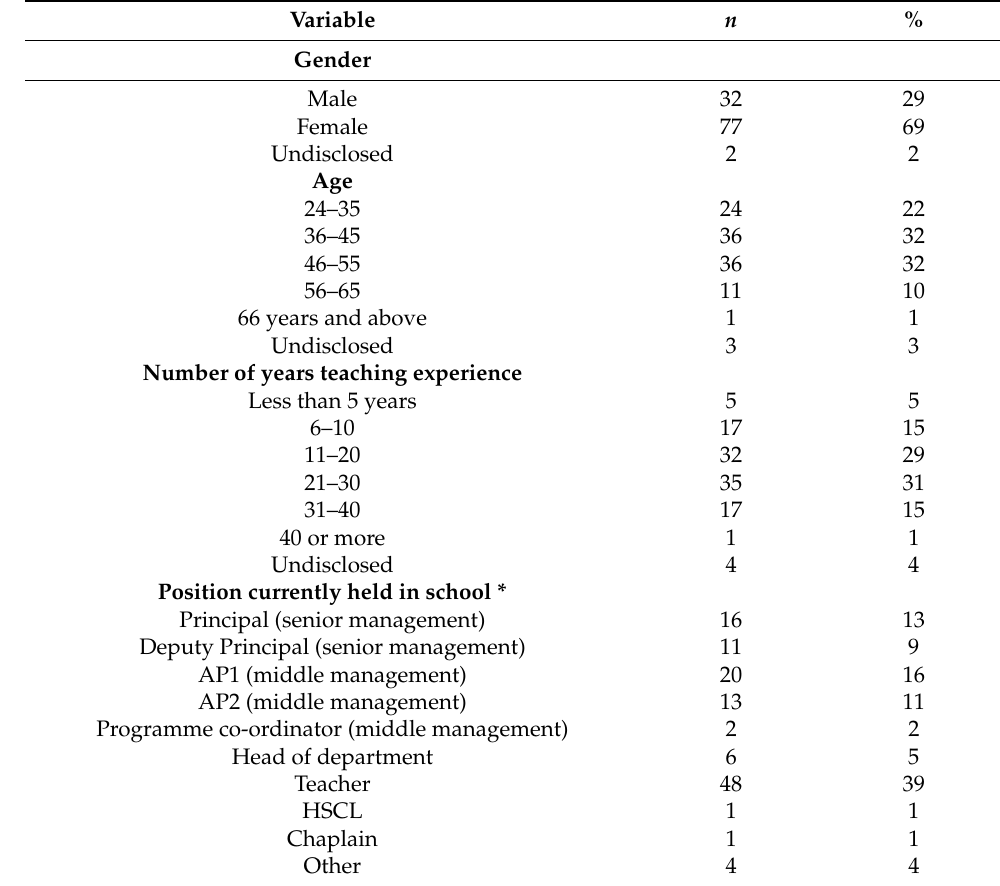
Table 1. Demographic data.